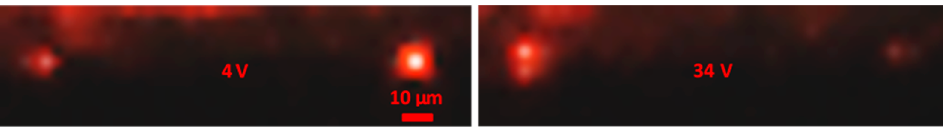
Figure 6. Typical output as captured by the camera. Clearly perfect extinction is not obtained when maximum intensity is transmitted, since the MMIs were designed for 1550 nm.